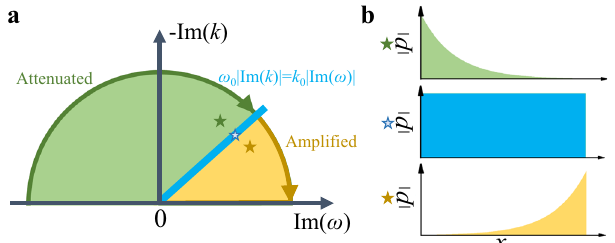
Fig. 1 | Conceptual illustration of the virtual gain effect. a The effects due to simultaneous modulations on k and ω in the complex plane. The green and yellow regions exhibitvirtualloss and gain effects, respectively. The blue line denotes the criticalpoints. b The fi elddistributions for the three cases that are markedasstars in ( a ).